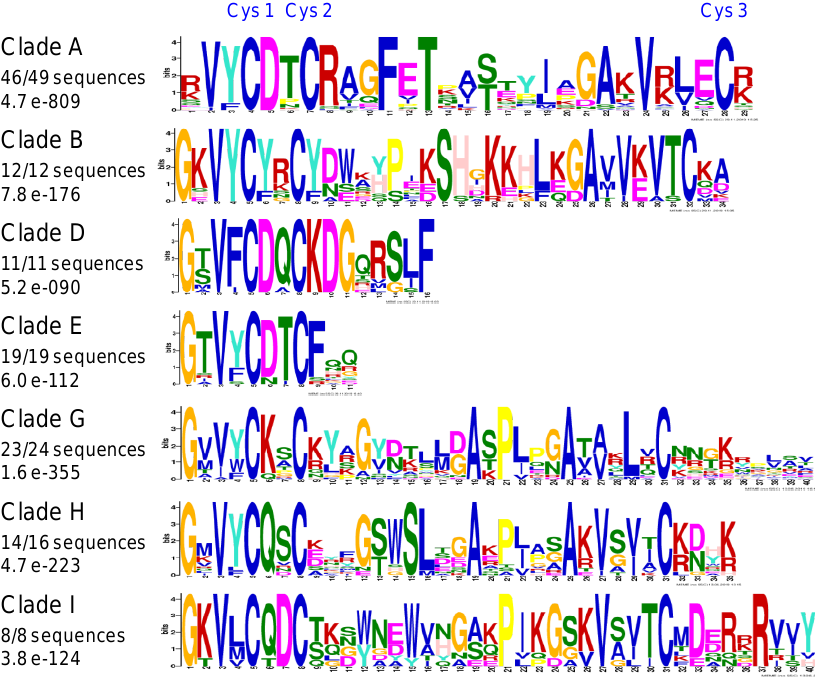
Figure 7. The most conserved motifs of PAC domains inside clades A, B, D, E, G, H, I in PDPs of A. trichopoda plant families appeared subsequently. The number of PAC domains in each clade is indicated as well as the score of the conserved motif according to the MEME software.